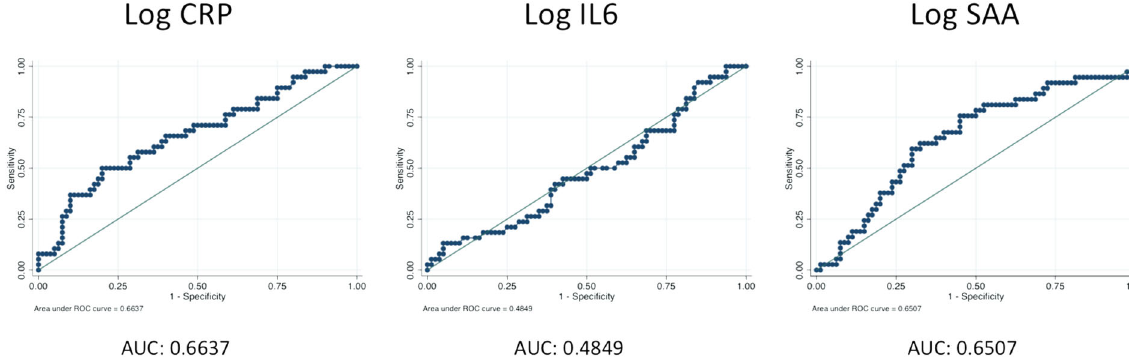
Fig. 2 Receiver operating characteristic curves for each in fl ammatory biomarker (HER2 −